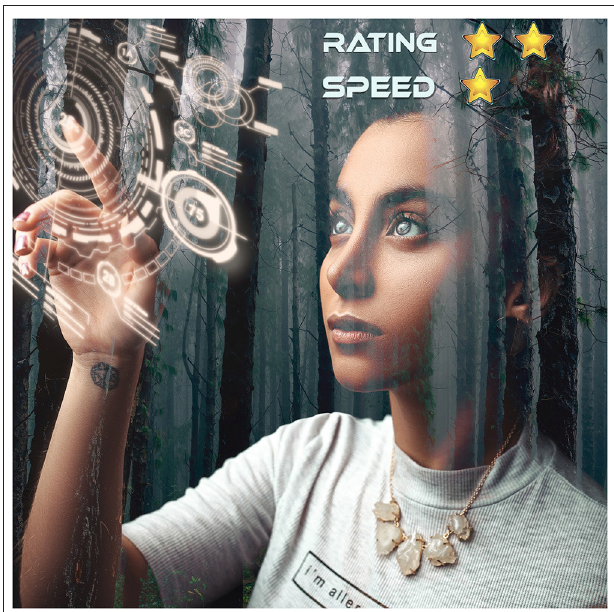
FIGURE 1 | In an office setting, gamification approaches can be specifically used for interpreting multidimensional forest data and to present it in a way which makes it possible to engage workers or analysts in a gameful